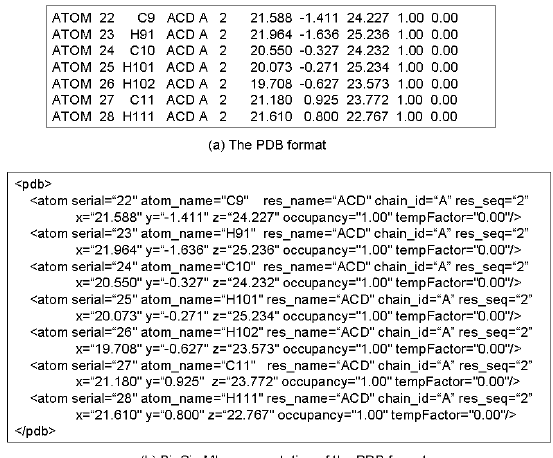
Figure 3: The arachidonic acid described in the PDB format and the BioSimML representation